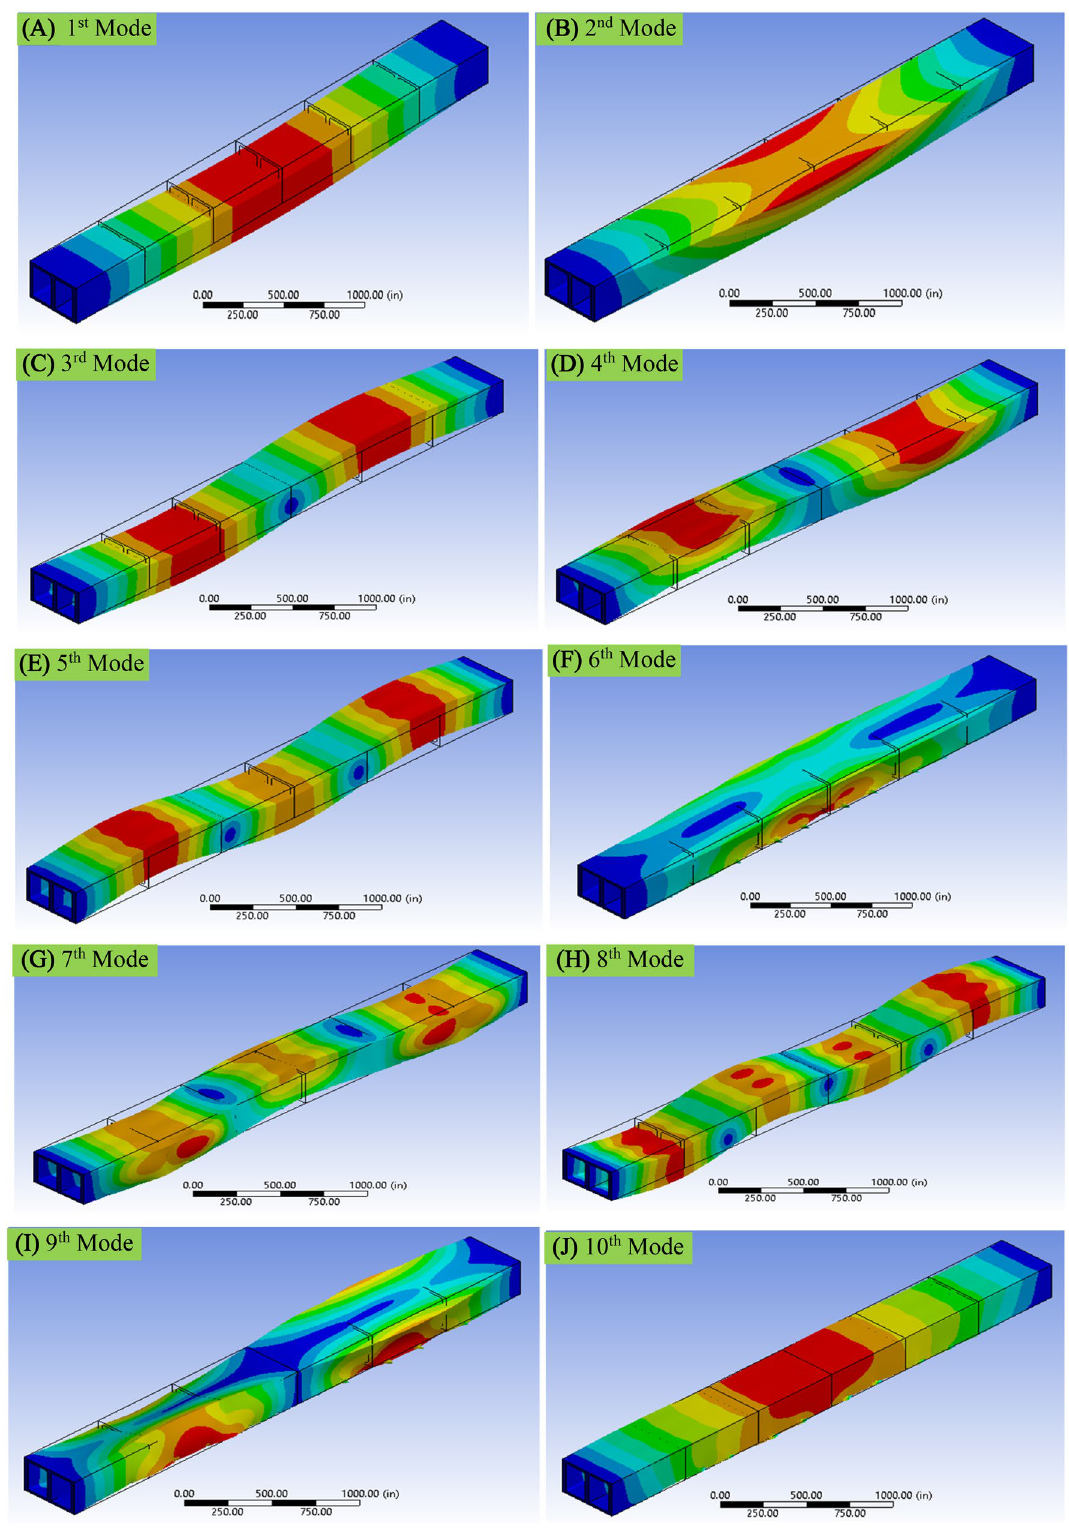
Fig. 4 Global mode